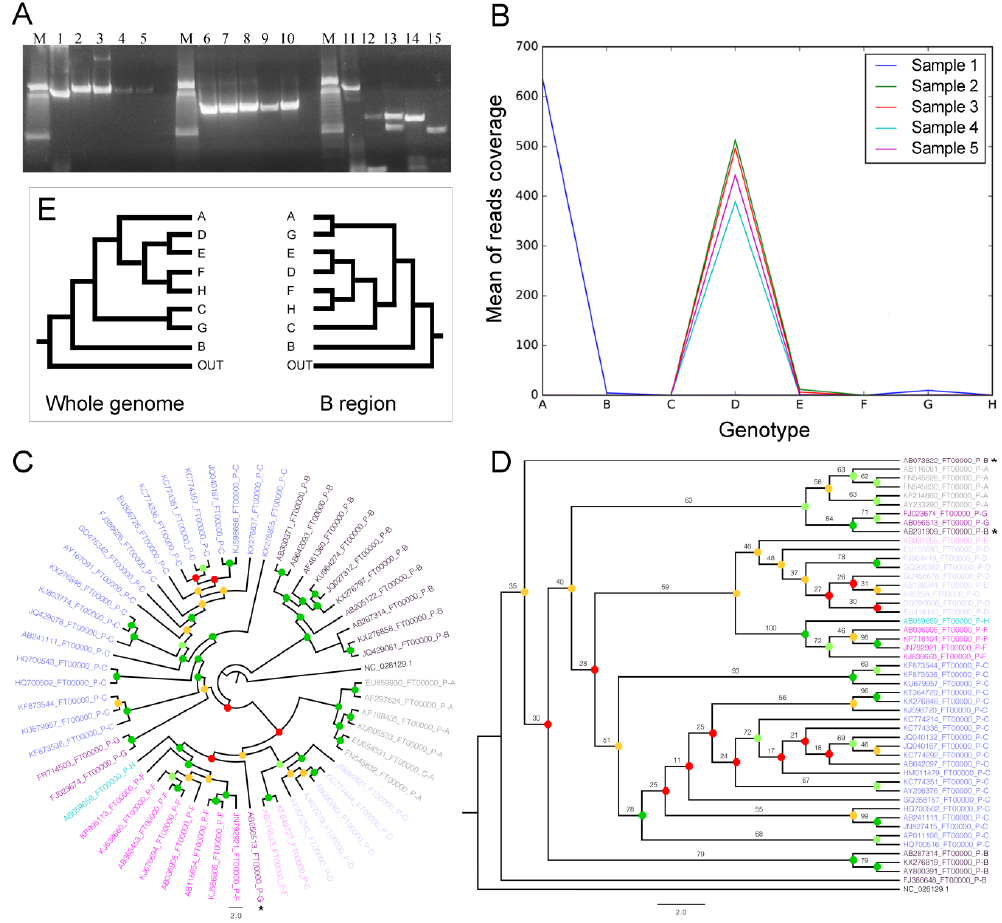
Figure 1. Electrophoresis, mapping, and phylogenetic trees (cladograms): ( A ) Hepatitis B virus (HBV) genome amplification from clinical samples. Amplicons from the A, B, and C regions were checked using an agarose gel stained with GelRed™. M represents the DNA Ladder 100 bp (Invitrogen, cat.15628-050). The strong reference band represents 600 bp. Lanes 1 to 5 represent amplicons from the A region. Lanes 6 to 10 represent amplicons from the B region and lanes 11 to 15 represent amplicons from the C region; ( B ) Mean of reads mapped over major HBV genotypes; ( C , D ) Phylogenetic trees inferred using whole genomes and using the B region, respectively. Bootstrap was binned with ranges 0–30, 31–60, 61–75, and 75–100, indicated by the red, orange, light-green, and dark- green circles, respectively. Bar, 0.2 modifications; ( E ) Synthesis of phylogenetic trees showing only genotype grouping.